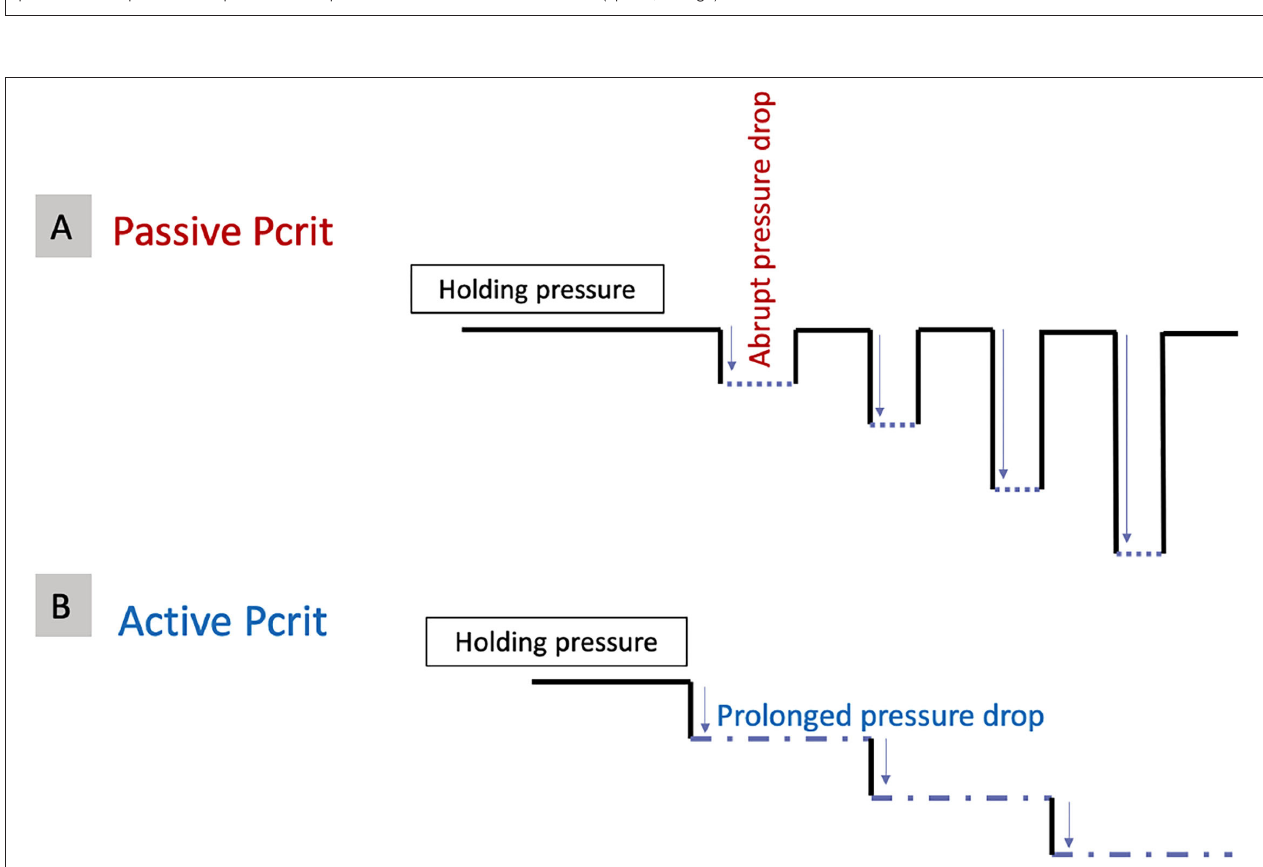
FIGURE 5 | Different methods to measure (A) Passive critical closing pressure (Pcrit) and (B) Active Pcrit.